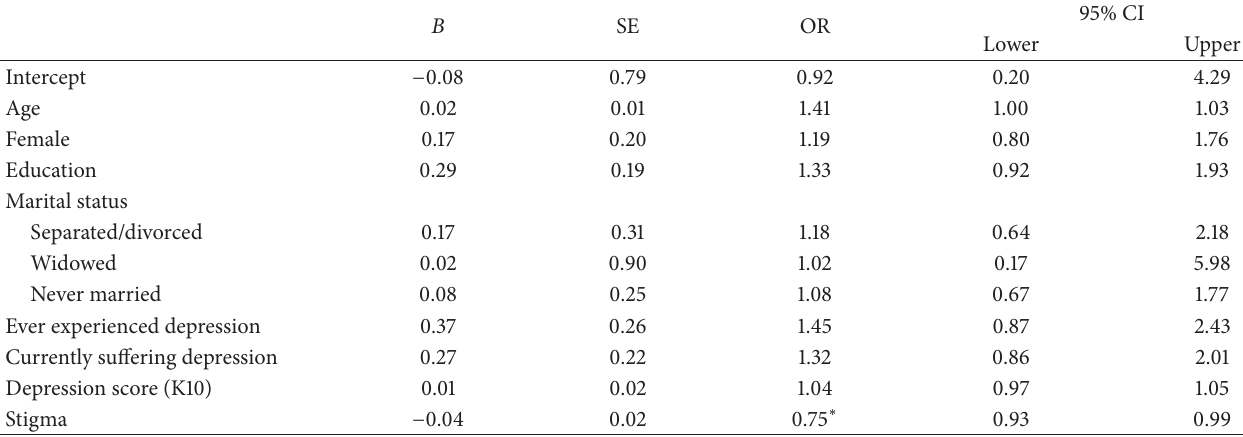
Table 3: Predictors of participation interest for eligible participants ( 𝑛 = 533